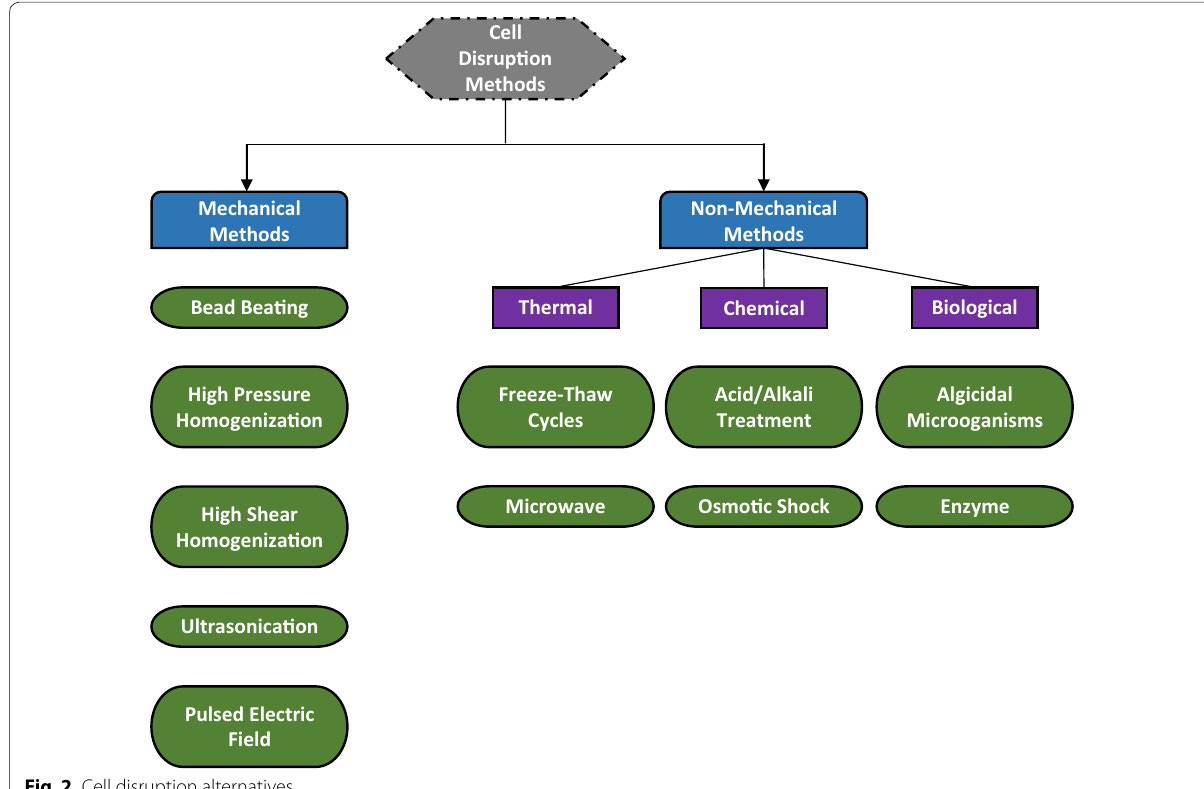
Fig. 2 Cell disruption